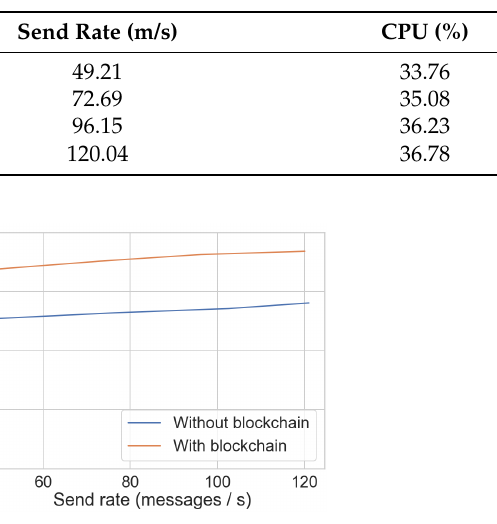
Table 4. CPU and memory usage for the SETS framework with blockchain.